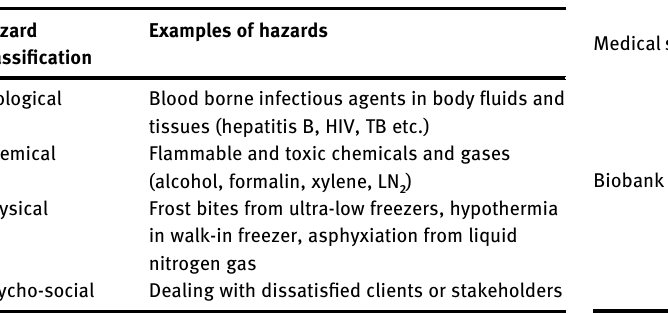
Table  : Hazardstothehealthandsafetyofemployeesandvisitors.